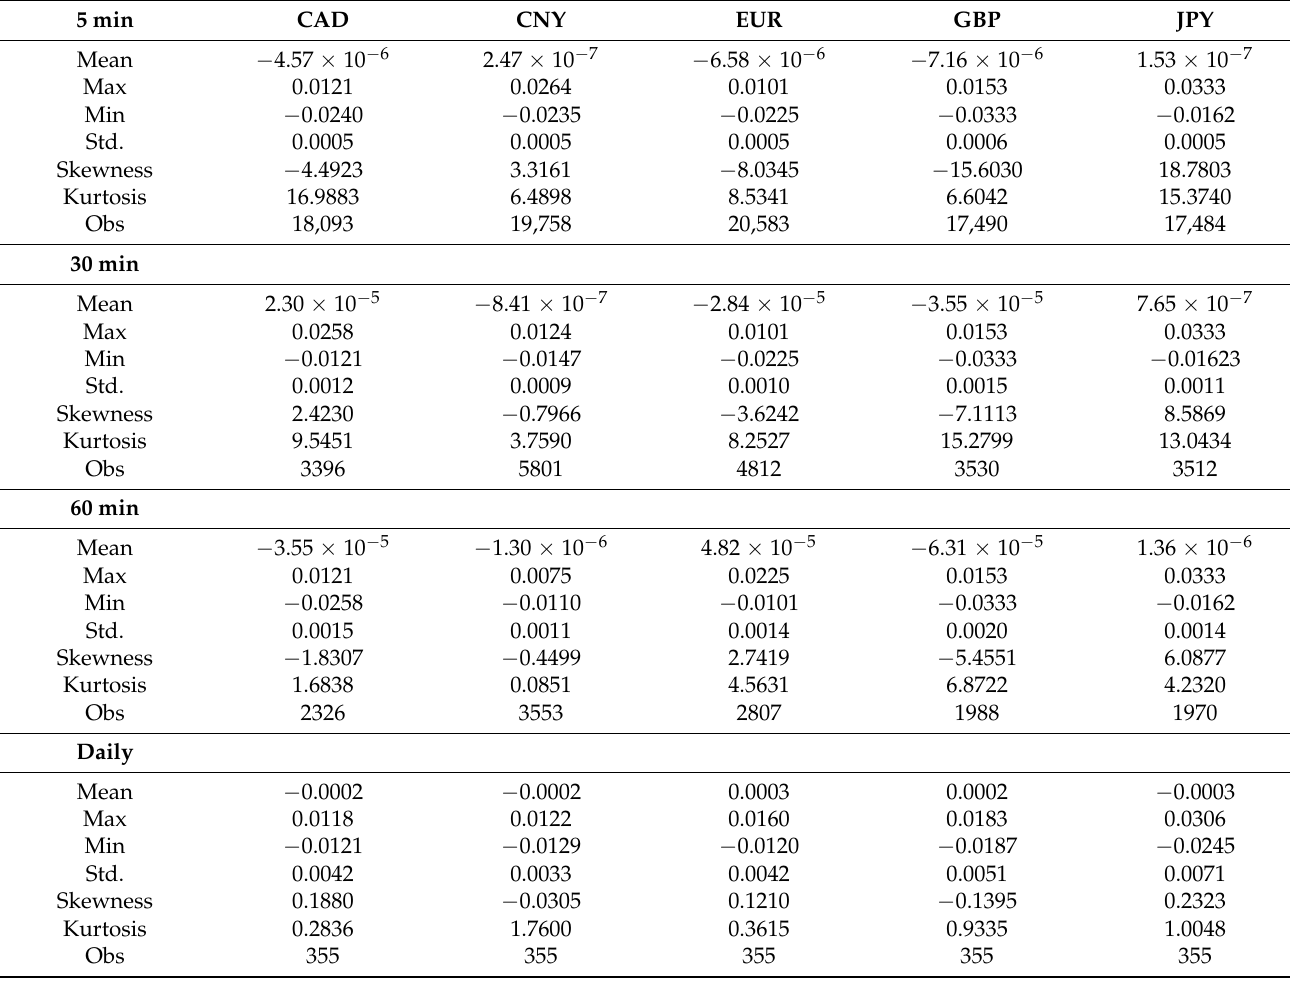
Table 2. Descriptive statistics of the currency returns with the American dollar as the base currency